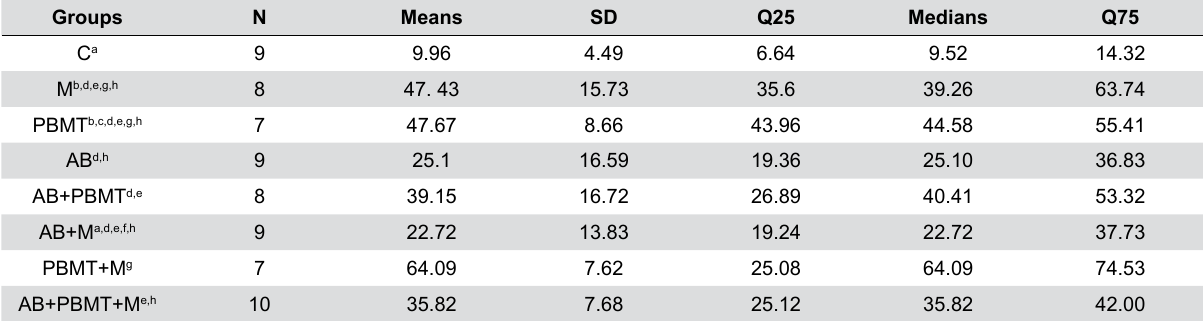
* Same letters represent no statistical difference (significance level of 5%). * Strength of the statistical test=99.8%, considering an alpha of 5%